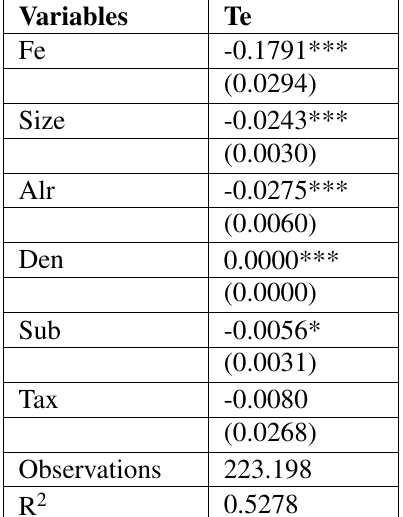
Table 3 Analysis of regression